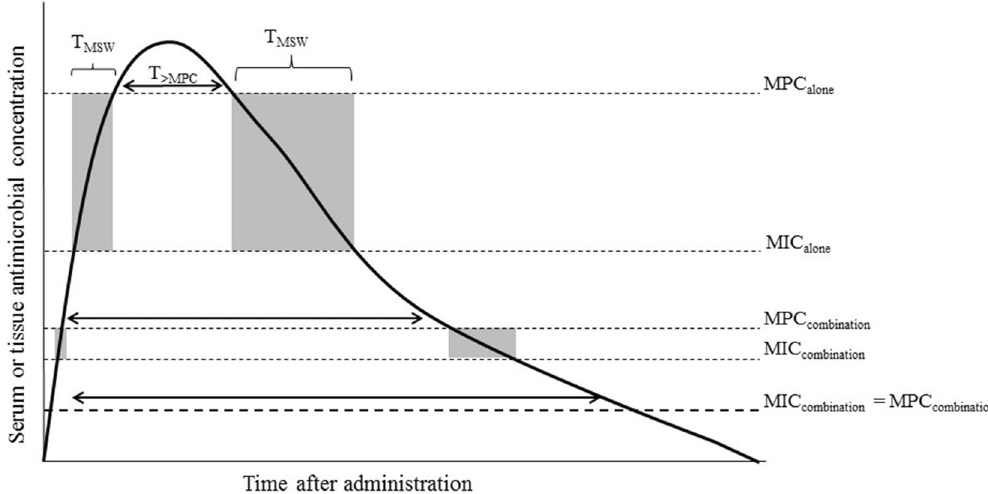
Figure 4. Schematic representation of the mutant selection window (MSW) of an antimicrobial agent alone and in combination with other drugs. As MIC and mutant prevention concentration (MPC) of the antimicrobial in the combination decrease, the time within the MSW (T MSW ) decreases or is even eliminated when MIC and MPC values are equal. Essentially, the longer the time spent by an antibiotic within the MSW, the greater the opportunity for resistant mutants to be selectively amplified. Dashed lines indicate the MIC and MPC; double- headed arrow indicates the time that drug concentration exceeds the MPC (T >MPC ); shaded region indicates the duration that drug concentration is within the